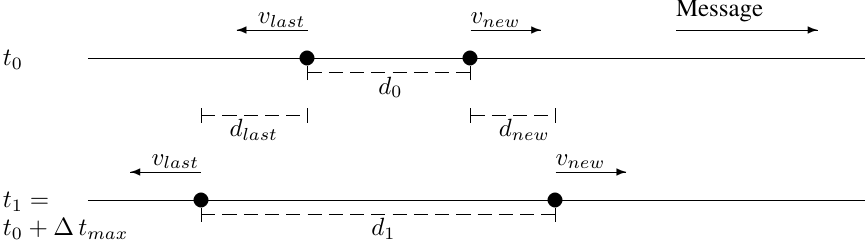
Figure 6. Case 4